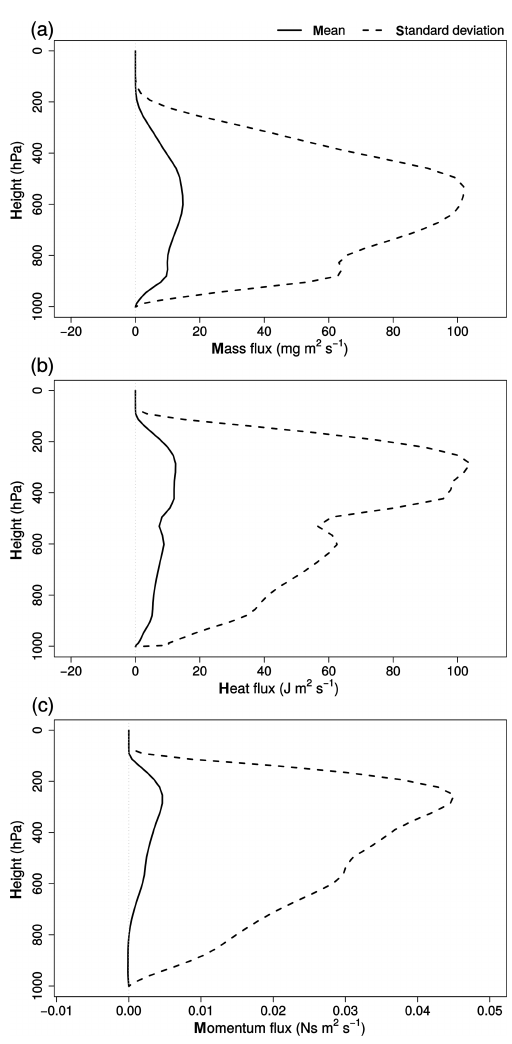
Figure 5. Vertical profile of the mean transport flux error (full line) and standard deviation (dashed line) for specific humidity (a) , en- thalpy (b) and zonal momentum (c)